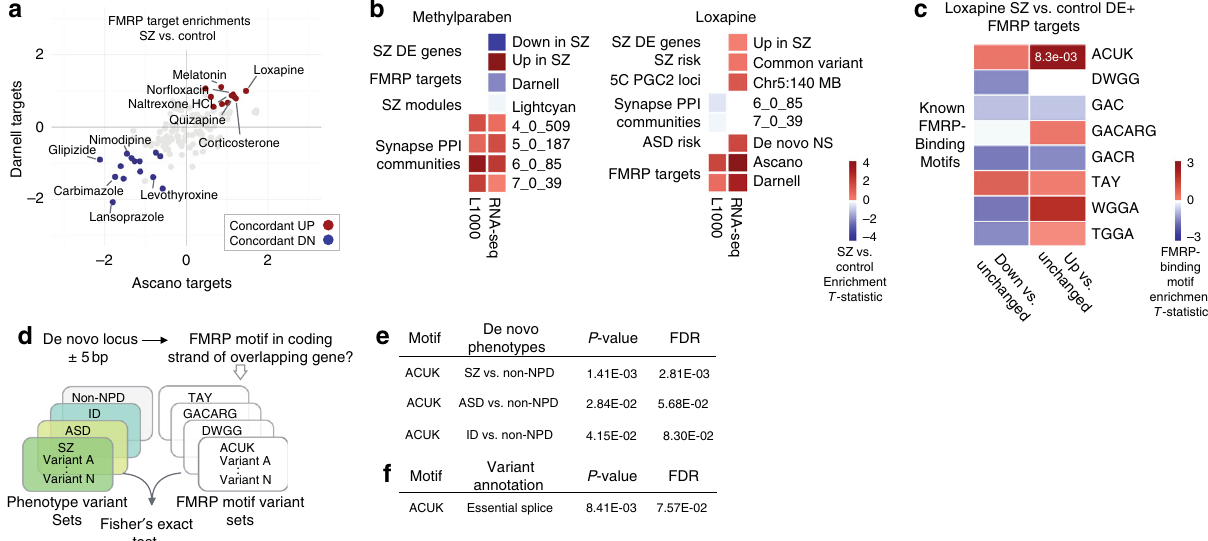
Fig. 6 Loxapine-induced regulation of FMRP targets implicates NPD-associated binding motifs. a Summary of diagnosis-dependent drug-induced perturbations in FMR1 protein (FMRP) targets from L1000 drug-screening data. Red (upregulation) and blue (downregulation) points indicate drugs that induce signi fi cant (FDR < 0.1) changes in the regulation of FMRP targets in SZ hiPSC NPCs in two FMRP target sets 42,43 . b SZ sets that are most differentially regulated by methylparaben and loxapine, across L1000 and RNA-seq. Squares with enrichment FDR > 0.1 are shown as white. c Known FMRP-binding motifs in DE genes of loxapine-treated SZ and control hiPSC NPCs. d FMRP targets enriched in loxapine-treated diagnosis-dependent hiPSC NPC DE genes were tested for association with SZ, ASD, and intellectual disability (ID) rare variant gene lists. e Enrichment for ACUK FMRP-binding motif